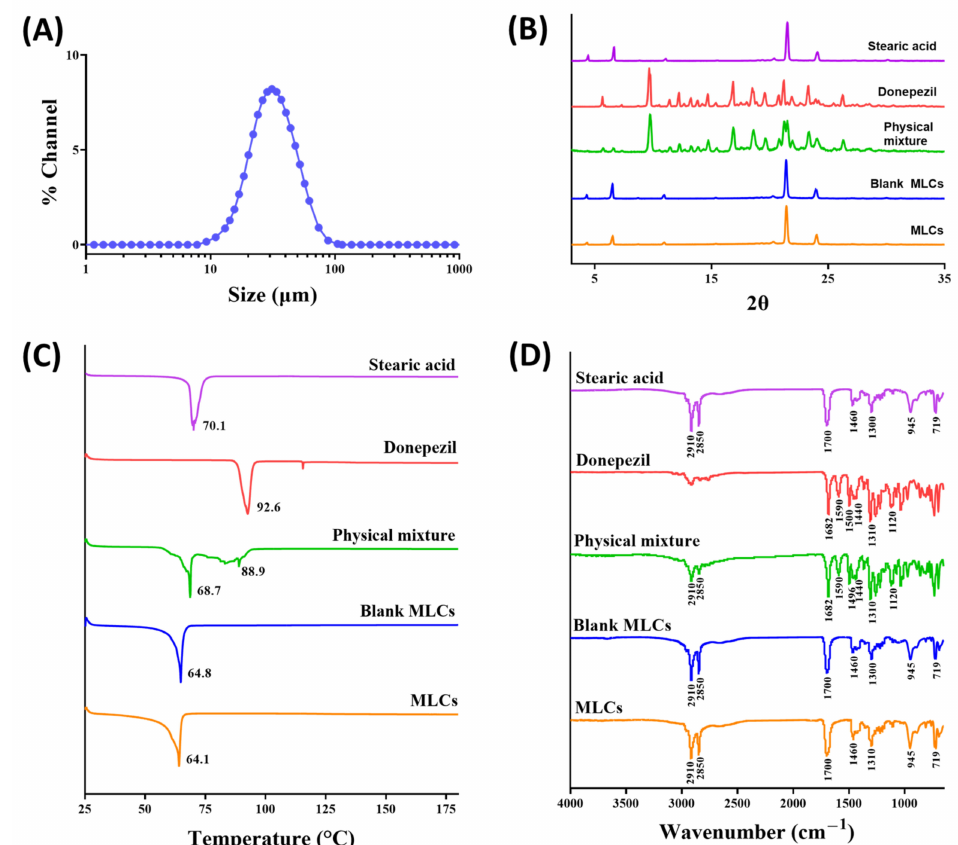
Figure 2. Characterization of the optimized MLCs. ( A ) Particle size distribution, ( B ) pXRD, ( C ) DSC, and ( D ) FT-IR